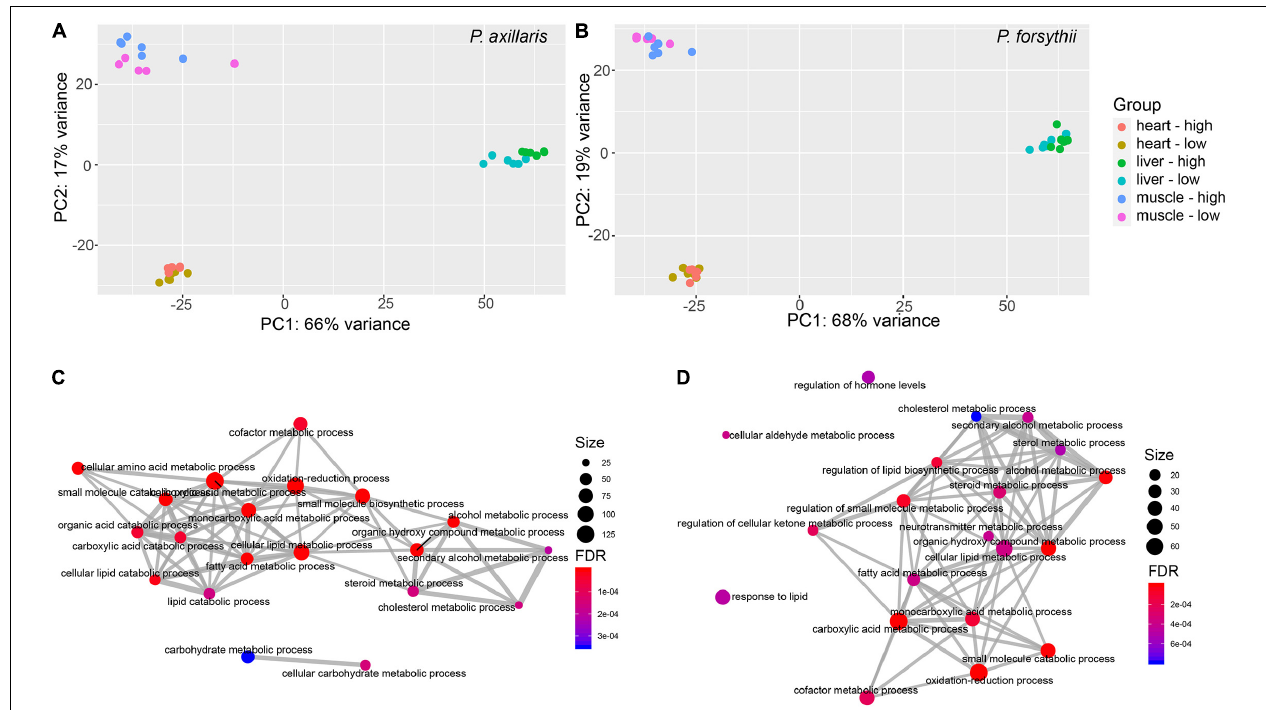
FIGURE 2 | Plasticity in gene expression profiles. (A) Principal component analysis (PCA) plot for expression profile of P. axillaris . The colors of dots represent the experimental groups. (B) PCA plot for expression profile of P. forsythii . (C) Network for overrepresented Gene Ontology (GO) categories for differentially expressed genes (DEGs) in liver of P. axillaris . (D) Network for overrepresented GO categories in the liver for P. forsythii . In the networks, the size of dots represents the number of genes in each category, and the FDR represents the p -values after multiple correction by false discovery rate.